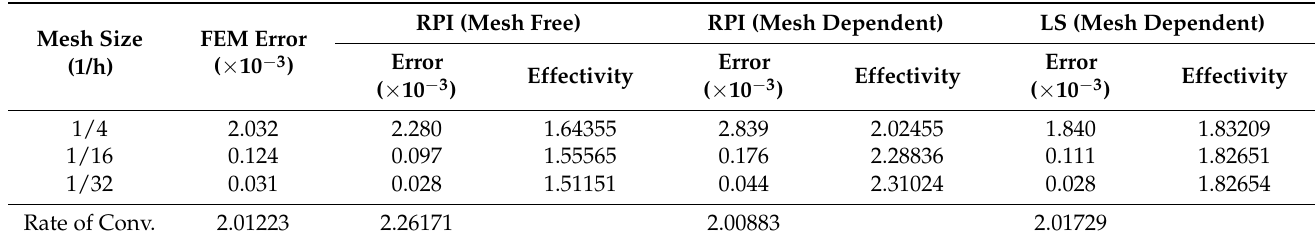
Table 3. Error convergence and global effectivity ( θ ) obtained for RPI (MQ) and least square based displacement recovery techniques (quadrilateral, L 2 norm).